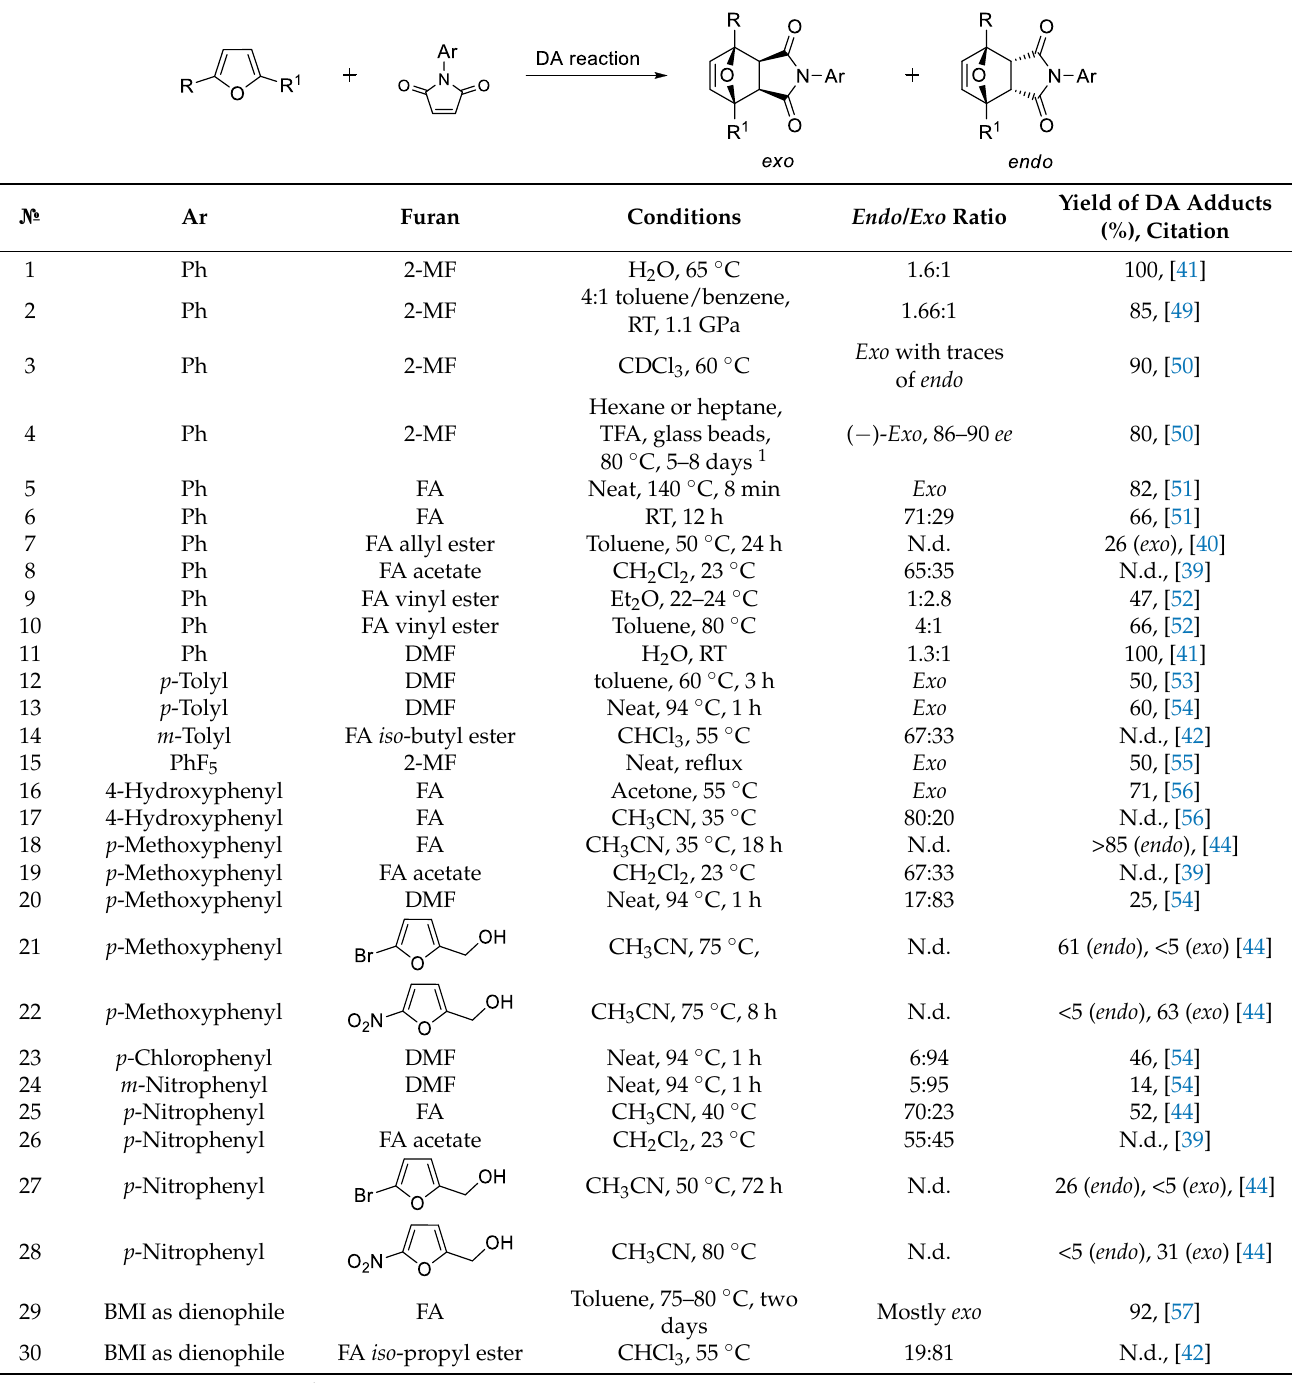
Table 2. Results of the reactions of N -aryl maleimides with biobased furans (selected examples).